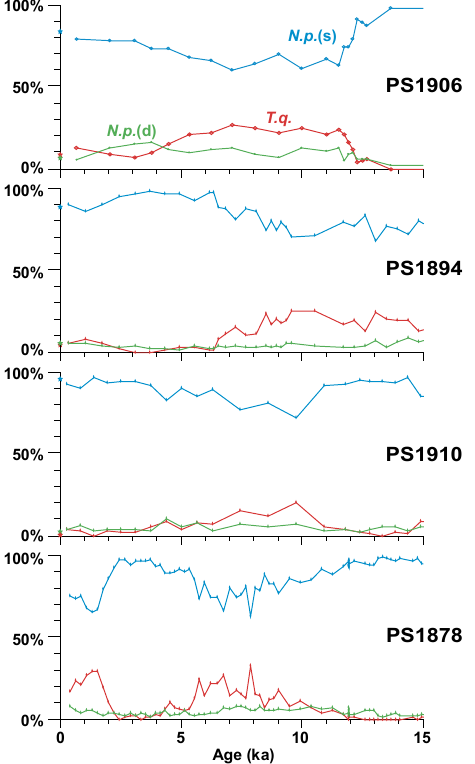
Fig. 9. Relative abundance of the three most common planktic foraminifera species in cores used in this study, plotted vs. age (since 15ka). Abbreviations as in Fig. 4. Asterisks mark the modern (core-top) values (own